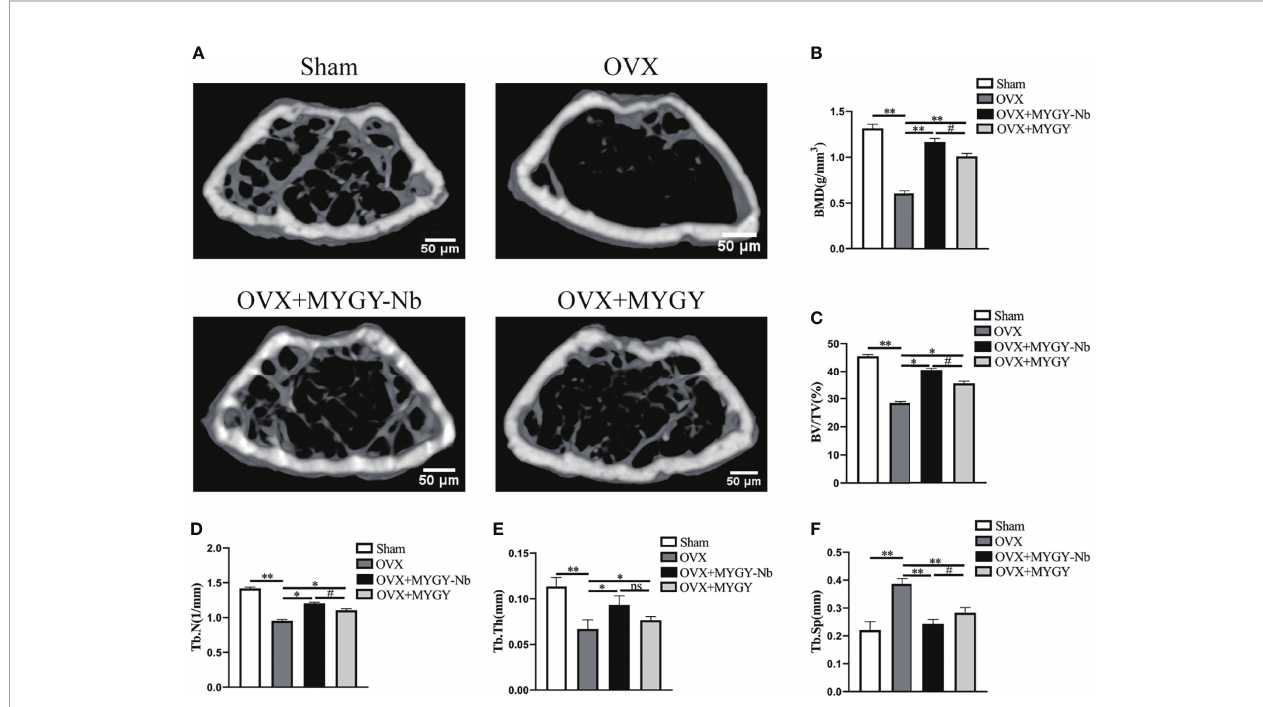
FIGURE 1 | Changes of bone structure in OVX mice, MYGY original formula and MYGY-Nb administration mice. (A) Representative m CT images. Quanti fi cation of microstructural parameters including BMD (B) , BV/TV (C) , Tb. N (D) , Tb. Th (E) and Tb. Sp (F) . Scale bars: 50 m m. Data were presented as means ± S.D. * P < 0.05; ** P < 0.01; ns: no signi fi cant difference; # P < 0.05. n = 6 in each